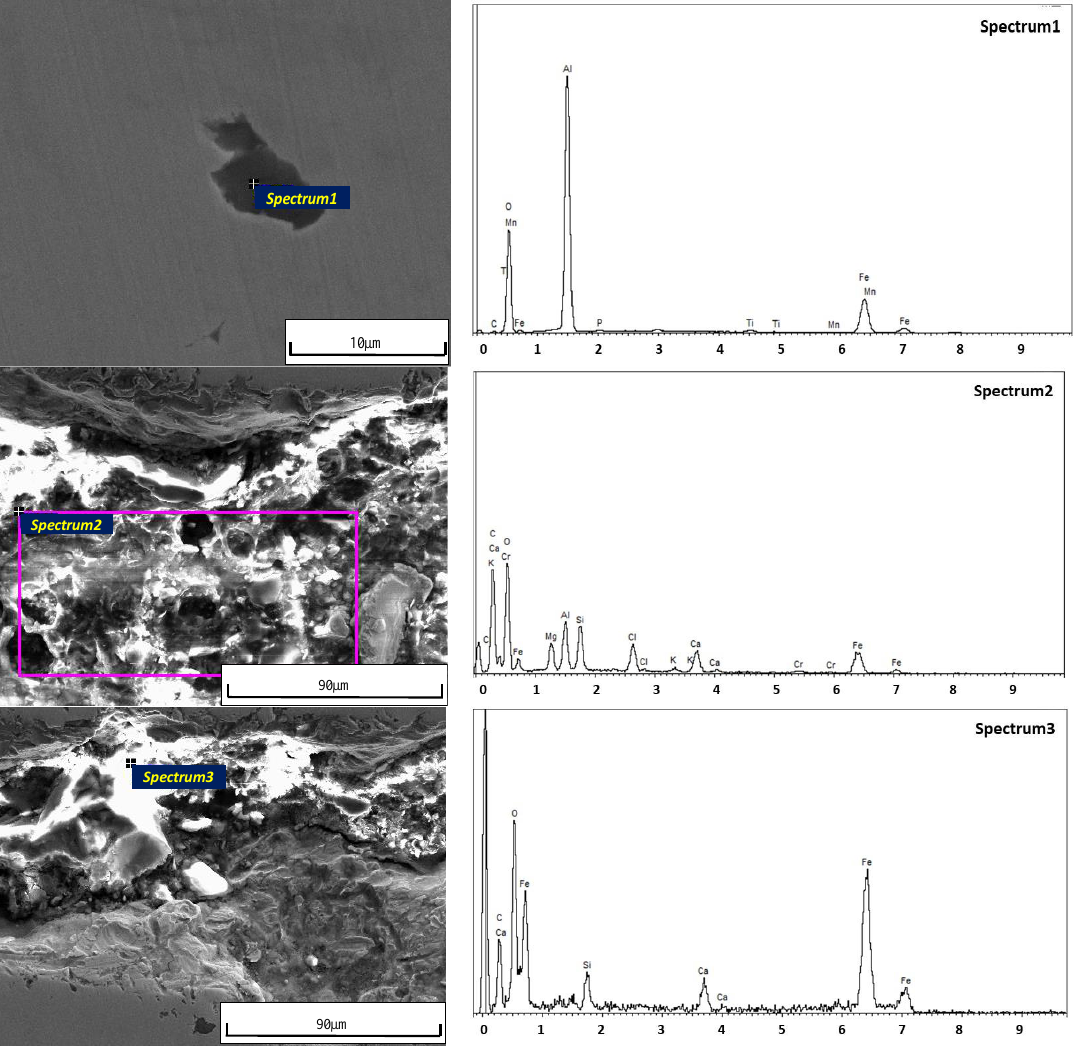
Figure 10. Morphology and compositions of microscopic inclusion in cracks.